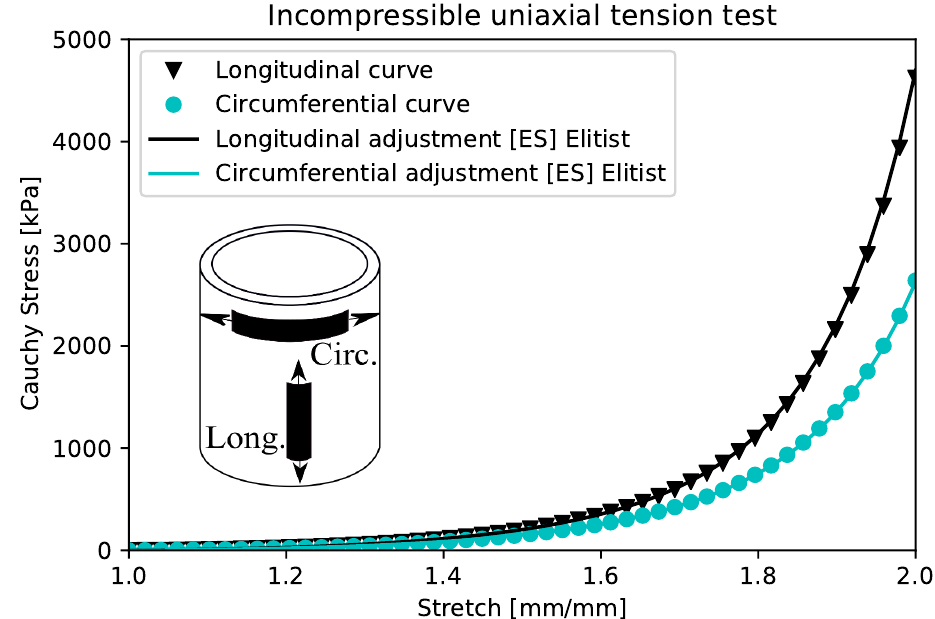
Figure 9. Adjustment of a known solution of an anisotropic material with evolutionary strategies.